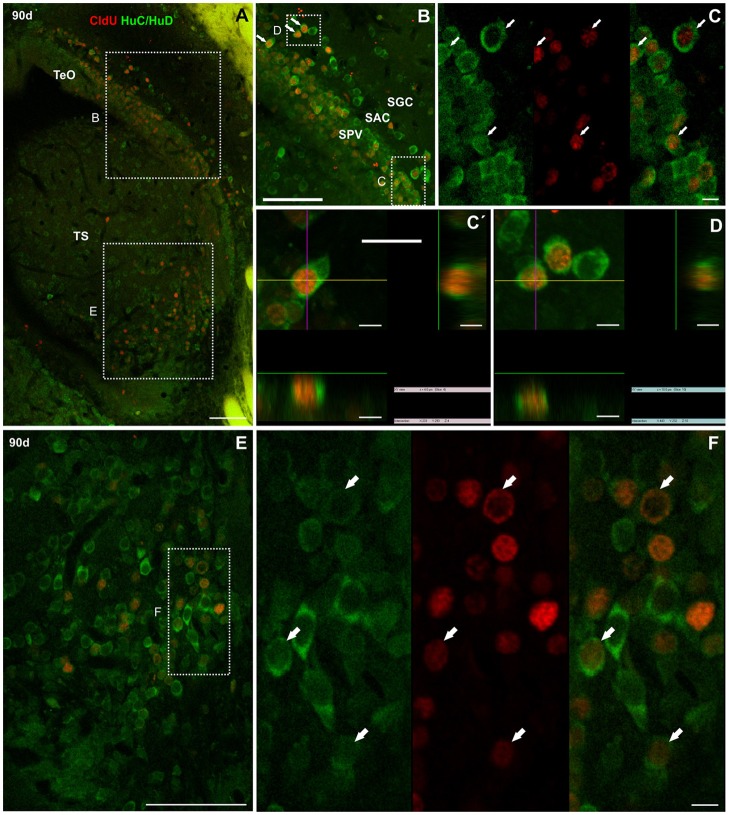
Neuronal differentiation in the tectum opticum and torus semicircularis at 90 and 180 days after four daily injections of CldU demonstrated by co-localization with HuC/HuD. (A) Maximal intensity projections of confocal microphotographs of a z stack (20 μm, every 0.5 μm) at the caudal pole of the tectum opticum (TeO) and torus semicircularis (TS). The dotted rectangles indicate location of two regions of interest observed at higher magnification in (B,E). Double labeling of tectal cells (B,C,C′,D) was confirmed by the microphotograph of each channel and of the overlay (C) as well as the x-z and y-z projection of two stacks (C′,D). Double labeling of toral cells is demonstrated in (F) by microphotographs of each channel and of the overlay of the region indicated by the dotted rectangle in (E). Scale bars: (A,B,E) 50 μm; (C,C′,D,F) 5 μm.